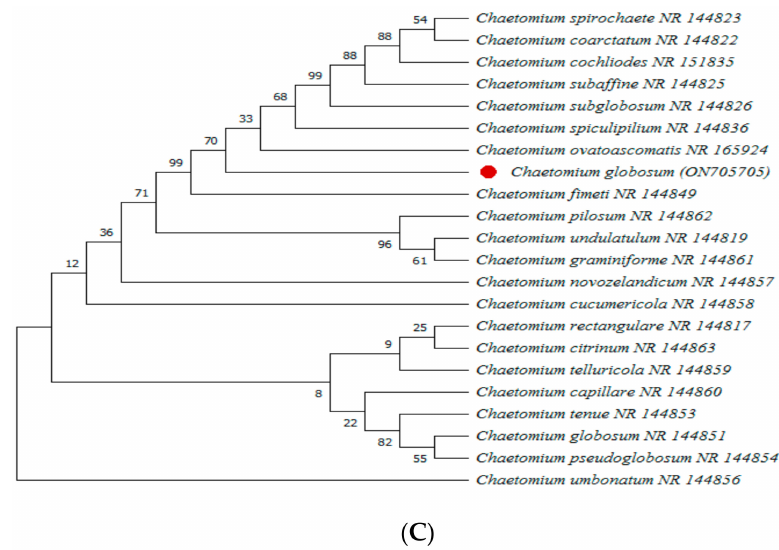
Figure 5. Phylogenetic trees of identified fungal bioagent isolates. Semistrict concurrence of most parsimonious trees based on ITS sequence data. This tree is overall compatible with highly sup- ported lineages according to the Bayesian 50% majority-rule consensus tree. Jackknife frequencies (10,000 replicates) are shown above each node. The dots in each figure represent the isolates identified in this study. A, Trichoderma harzianum , B, Trichoderma longibrachiatum and C, Chaetomium globosum .